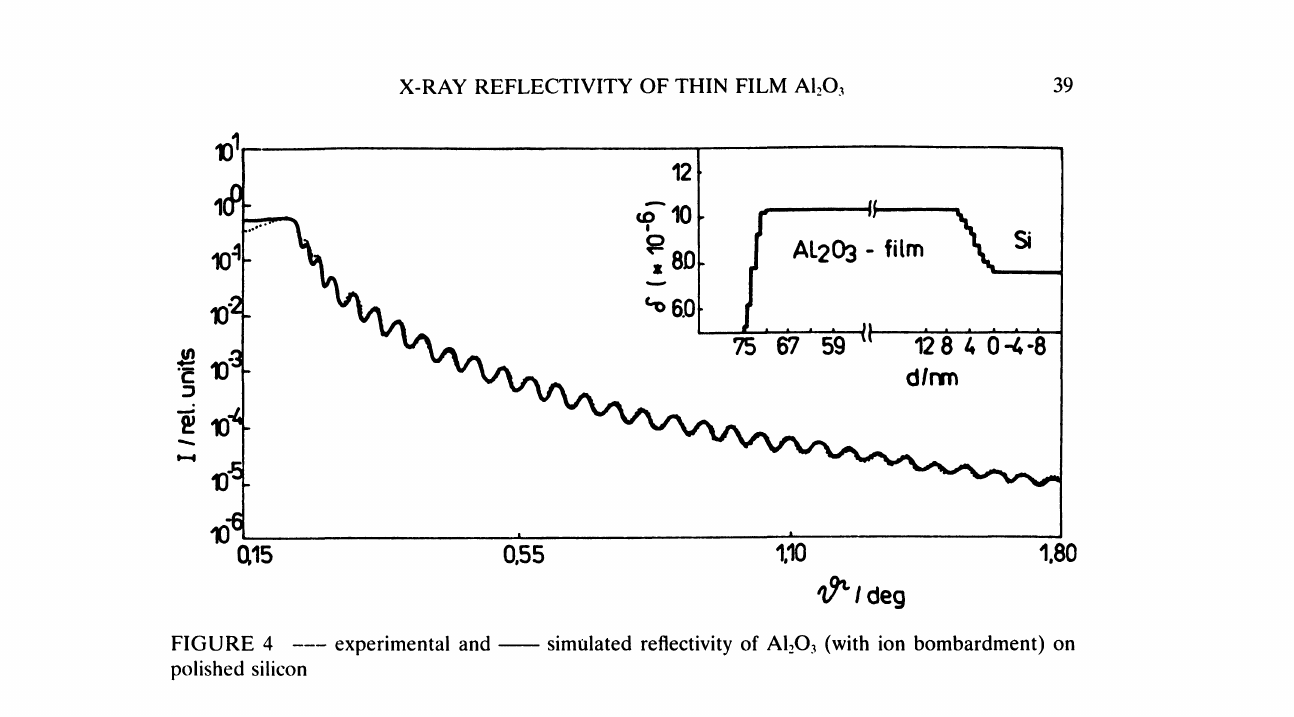
simulated reflectivity of AI_O3 (with ion bombardment)